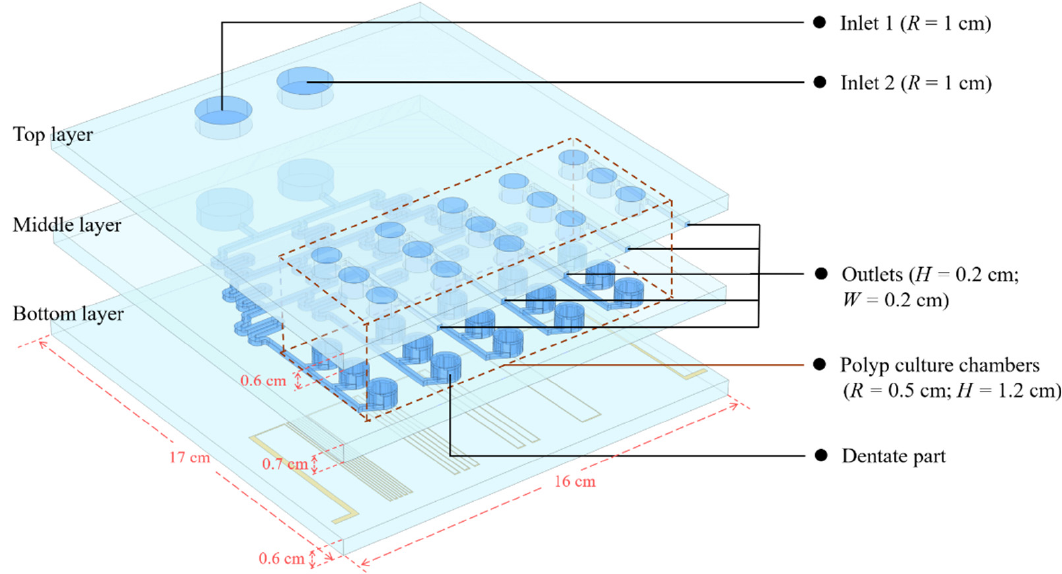
Figure 2. The structure diagram of the microfluidic polyp culture chip.